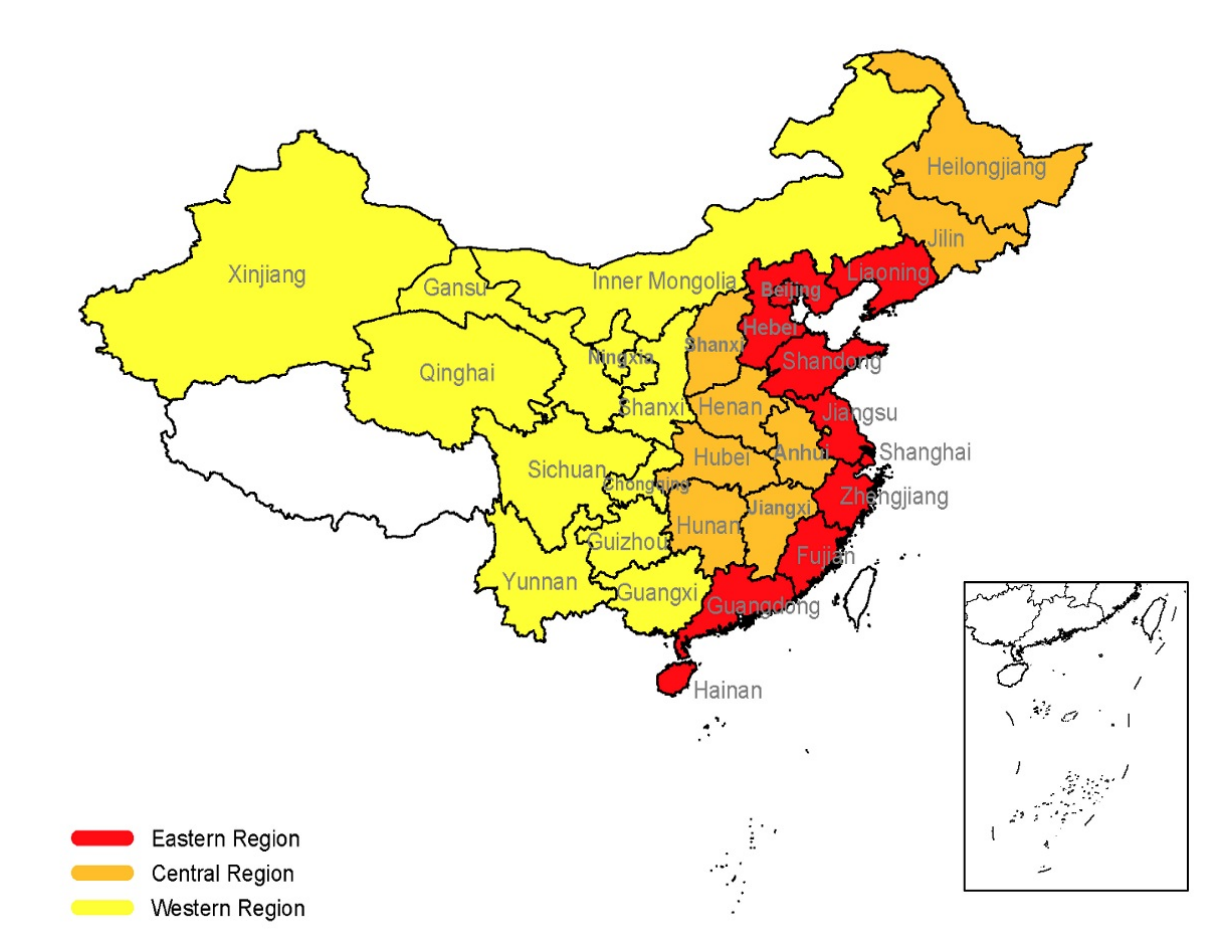
Figure 1. Distribution of the survey coverage areas in